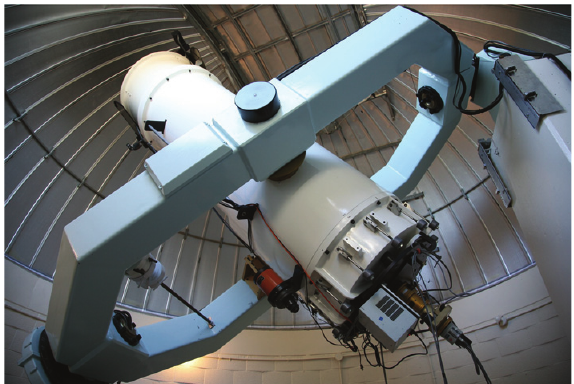
Figure 3: 31 (cid:3)(cid:3) telescope and PCCD